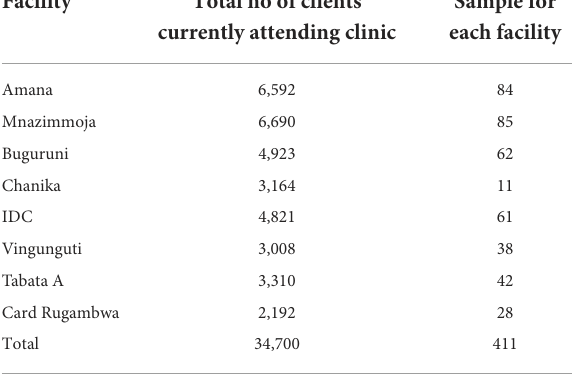
TABLE 1 Proportionate sample size per facility. TABLE 2 Socio-demographic characteristics of women and their partners ( n =